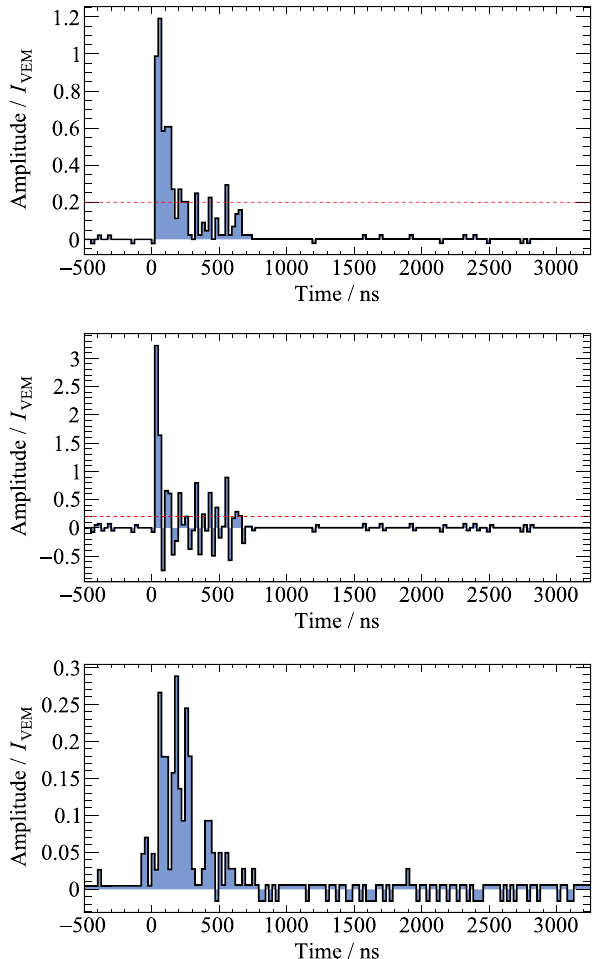
Fig. 19 Top: Example waveform which passes the ToTd algorithm. Middle: The deconvolution (Eq. (A.1)) of the first waveform along with the threshold to pass the algorithm (dashed red line). Bottom: Example waveform which passes the MoPS algorithm